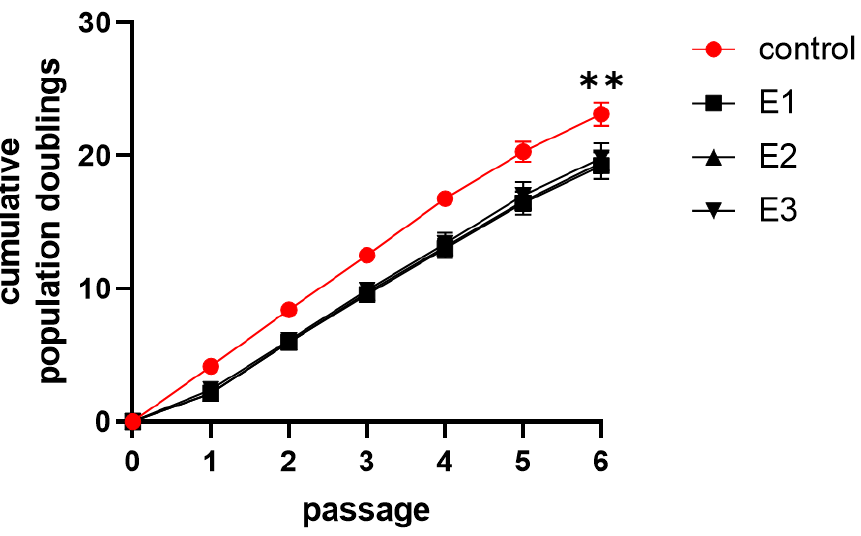
Figure 3. Cumulative population doublings during the cultivation. The graph demonstrates cumulative proliferation doublings of dental pulp stem cells as a mean of cell lines 1–5 with SEM plotted as error bars in experimental passages. Cells were cultivated in the control (control) and experimental media 1–3 (E1–3). Statistical analysis was performed using Friedman’s test followed by Dunn’s post hoc test; ** p < 0.005. Individual graphs for each cell line are enclosed in supplementary data as Figure